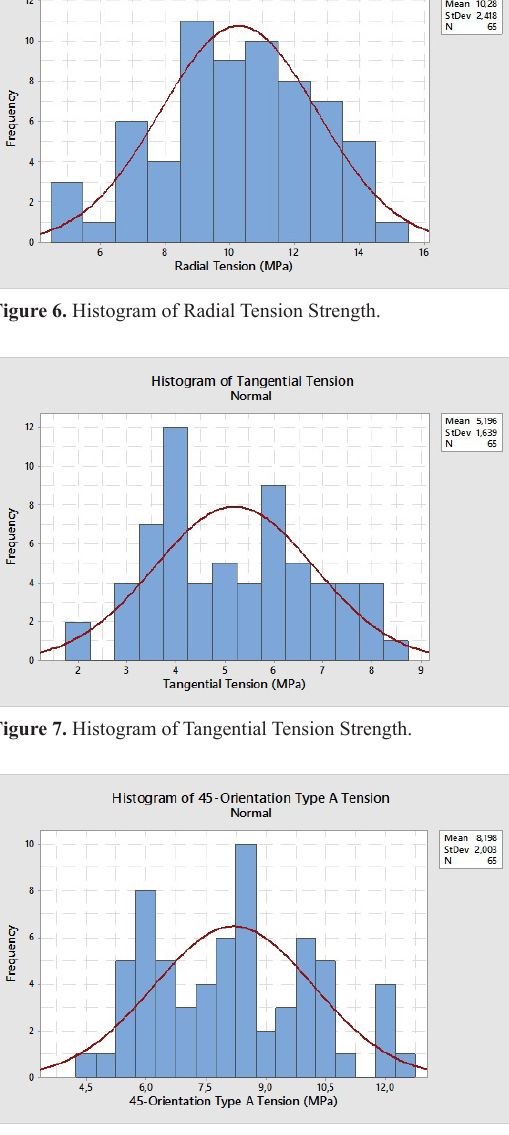
Figure 8. Histogram of 45-degree A Orientation Strength.